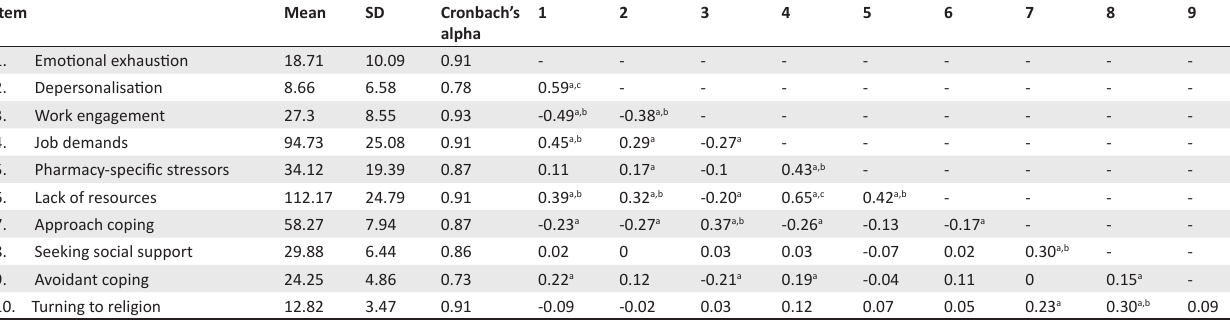
TABLE 2: Descriptive statistics, alpha coefficients and correlations of the MBI, UWES, PSI and COPE.